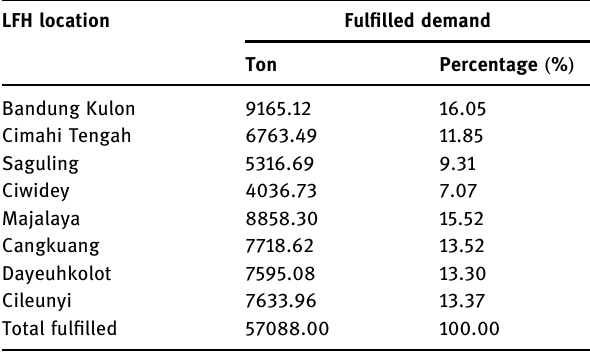
Table 2: Ful fi lled rice demand from local food hub ( LFH ) LFH location